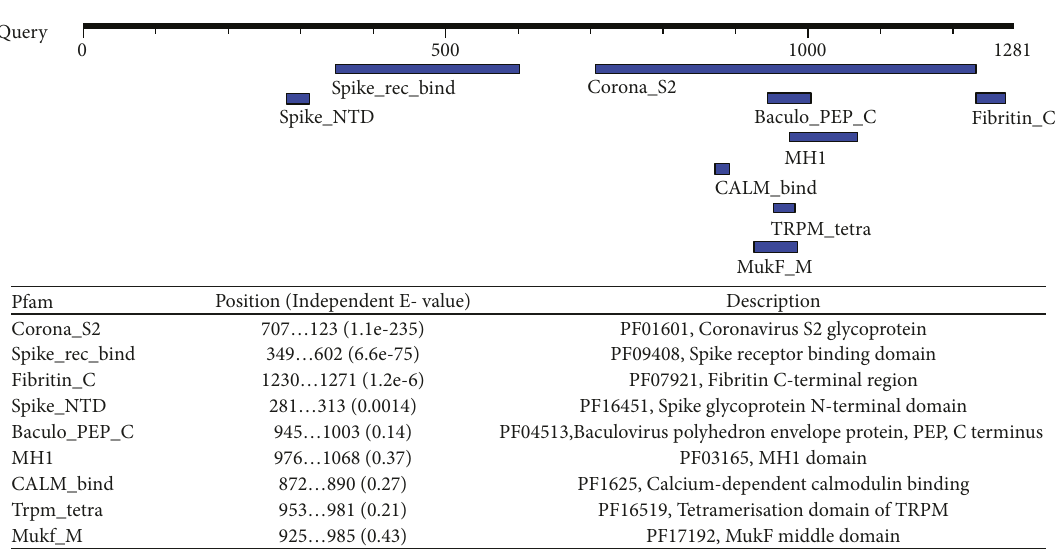
Figure 10: Result of motif finder in